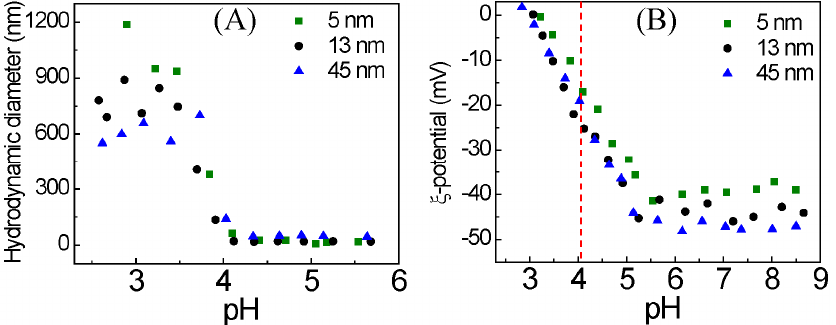
Figure 2. ( A ) Hydrodynamic diameter of the AuNP-MUA as a function of pH; and ( B ) ζ-potential of the AuNP-MUA as a function of pH. The red line indicates the onset of AuNP-MUA aggregation based on the hydrodynamic diameter data from figure A.